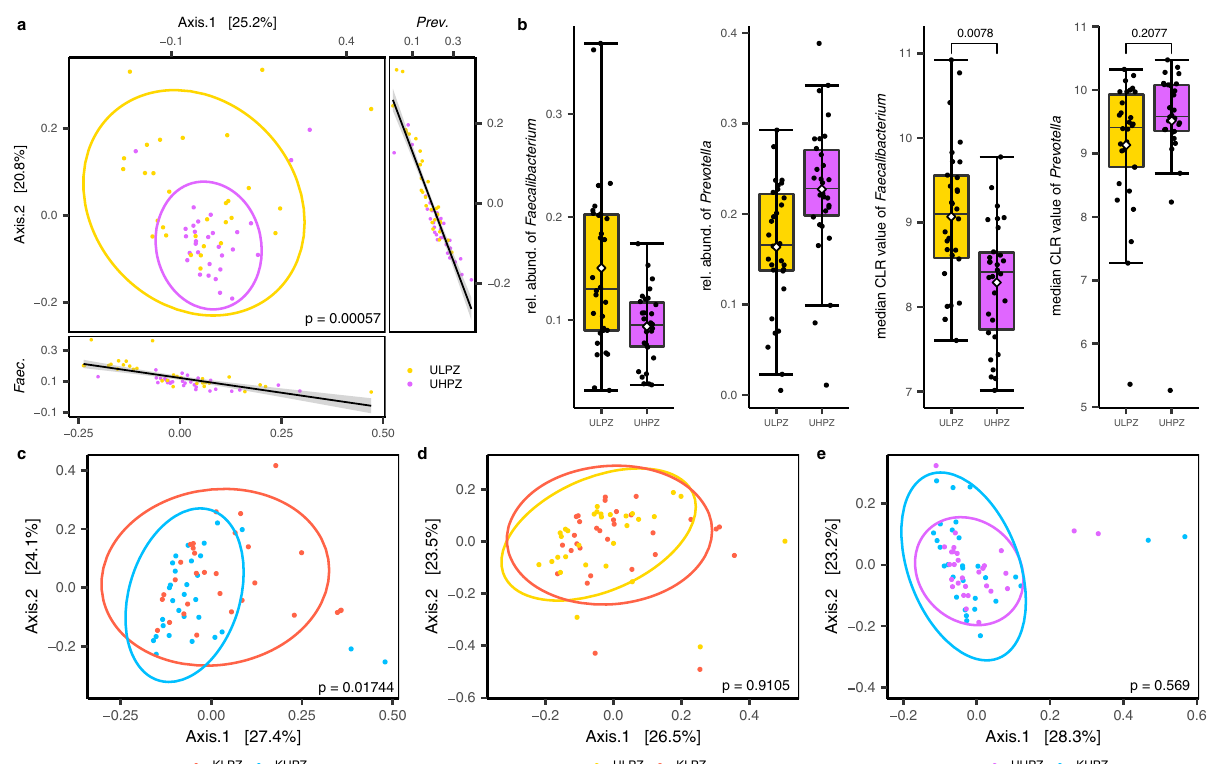
Fig. 5 Global measures of gut bacteria dissimilarity at the genus level for the Kahemba region. PCoA representations based on Bray-Curtis dissimilarity matrix values at the genus taxonomic level for a Unaffected children from the low prevalence zone (ULPZ) vs. Unaffected children from the high prevalence zone (UHPZ); correlations were generated using Spearman ’ s Correlation method of genus relative abundance against principal coordinate 1 and 2 axis values for each sample, and standard error with a 0.95 con fi dence interval is shown in gray with the regression line b Distribution of the relative abundance and normalized CLR medians of both Prevotella and Faecalibacterium genera between unaffected children from the LPZ ( n = 30) and HPZ ( n = 30). Data are represented as boxplots where the diamond denotes the mean, middle line in the box is the median, the lower hinge is the fi rst quartile, the upper hinge is the third quartile, and the whiskers extend from the lower and upper hinges to the smallest and largest value, respectively, at most to 1.5 * IQR (IQR, interquartile range, is the distance between the fi rst and third quartile), with each individual value plotted. c PCoA representations based on Bray-Curtis dissimilarity matrix values at the genus taxonomic level for Konzo-affected children from the low prevalence zone (KLPZ) vs. Konzo-affected children from the high prevalence zone (KHPZ). PCoA representations based on Bray-Curtis dissimilarity matrix values at the genus taxonomic level for d Unaffected children from the LPZ vs. konzo-affected children from the LPZ of Kahemba and e Unaffected children from the HPZ vs. konzo-affected children from the HPZ of Kahemba. Statistics for Bray-Curtis dissimilarity were generated using